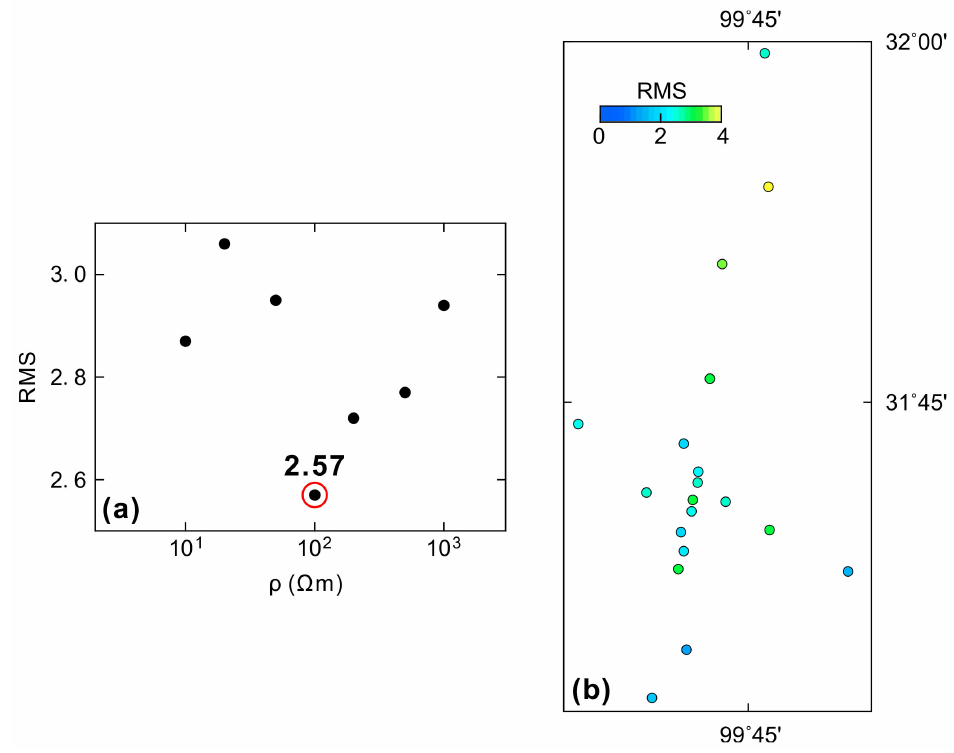
Figure 6. ( a ) The final root mean square (RMS) misfit of the inversion with various initial resistivities (10, 20, 50, 100, 200, 500, and 1000 Ω m). ( b ) Map of the site with RMS misfits in the final 3D inversion with the initial resistivity model of 100 Ω